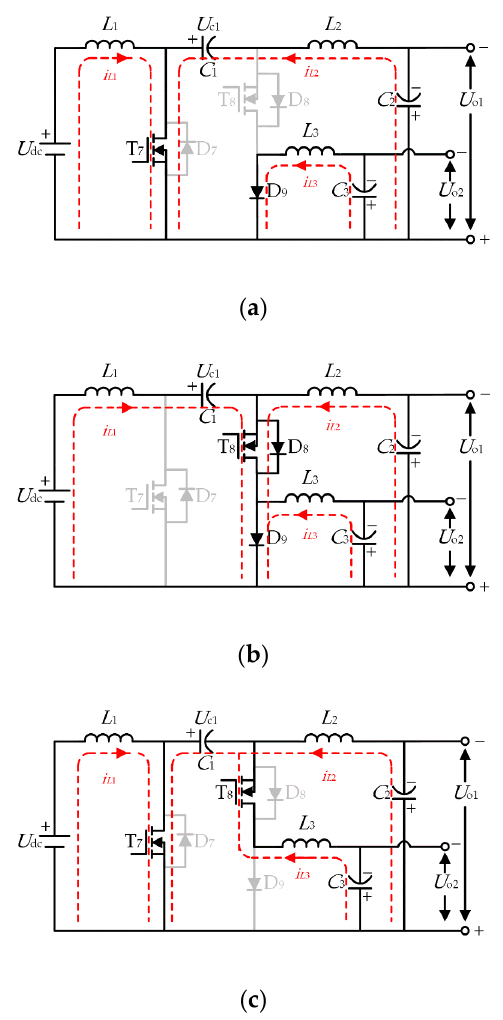
Figure 2. The equivalent circuits of the SIDO Cuk converter operation: ( a ) T 7 on, T 8 off; ( b ) T 7 off, T 8 on; and ( c ) T 7 on, T 8 on.